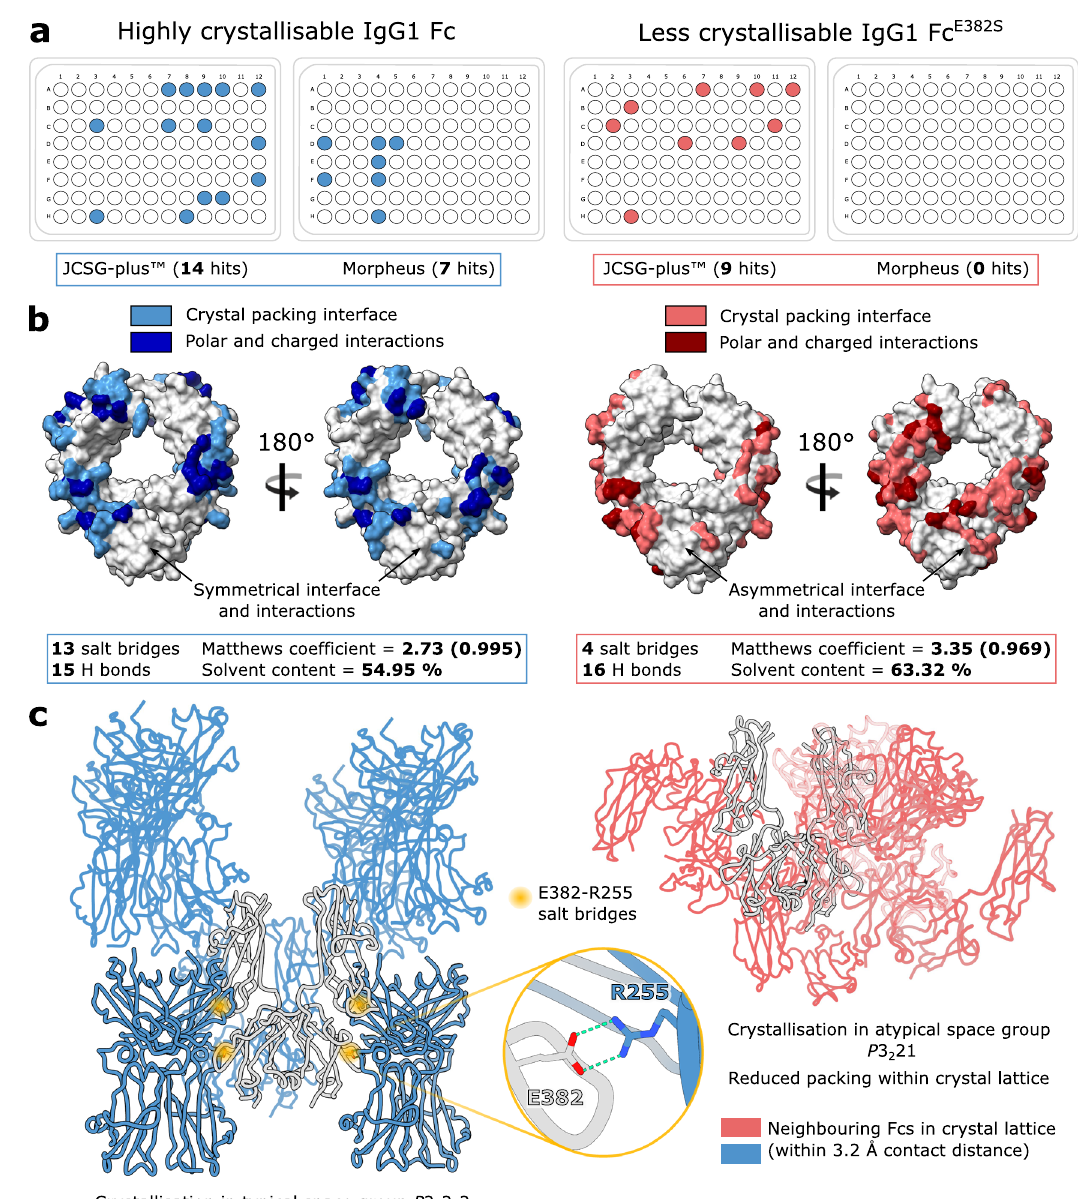
Fig. 1 | Observed crystal packing in wild-type and “ less crystallisable ” IgG1 Fc fragments. a Crystallisation of wild-type IgG1 Fc and IgG1 Fc E382S variant in JCSG- plus ™ and Morpheus screens, at 10mg/mL and 21°C. Crystal “ hits ” are indicated with a coloured circle. b Analysis of crystal packing interface and interactions present in a typical, wild-type IgG1 Fc crystal structure (PDB ID 3AVE) and IgG1 Fc E382S variant, as calculated by PDBePISA 35 . c Crystal packing resulting from